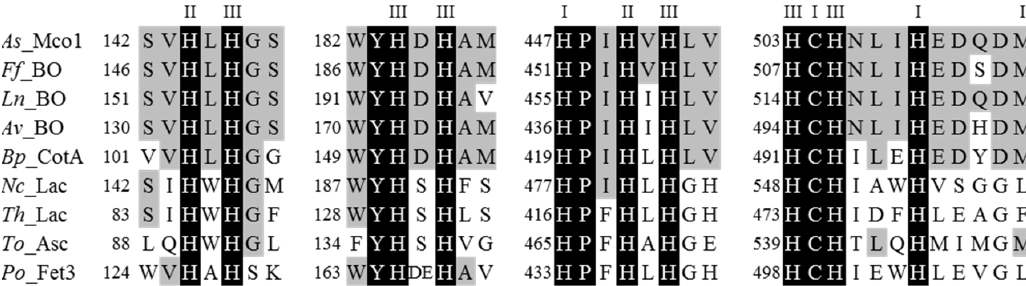
Figure 2. Amino acid sequence alignment of the four conserved Cu-binding regions in A. strictum KR21-2 ( As ) Mco1 and related MCO proteins including fungal bilirubin oxidases (BO), laccases (Lac), L-ascorbate oxidase (Asc), Fet3 ferroxidase, and bacterial CotA protein. Ff , Fusarium floridanum ; Ln , Lophiotrema nucula ; Av , Albifimbria verrucaria ; Bp , Bacillus pumilus ; Nc , Neurospora crassa ; Th , Trametes hirsuta ; To , Tolypocladium ophioglossoides ; Po , Pleurotus ostreatus . The Cu-binding T1, T2, and T3 residues are represented by I, II, and III, respectively. For accession number of each sequence, see Figure S2. In fungal proteins, the positions of amino acid residues were counted for the polypeptide accompanied by N-terminal signal sequence.